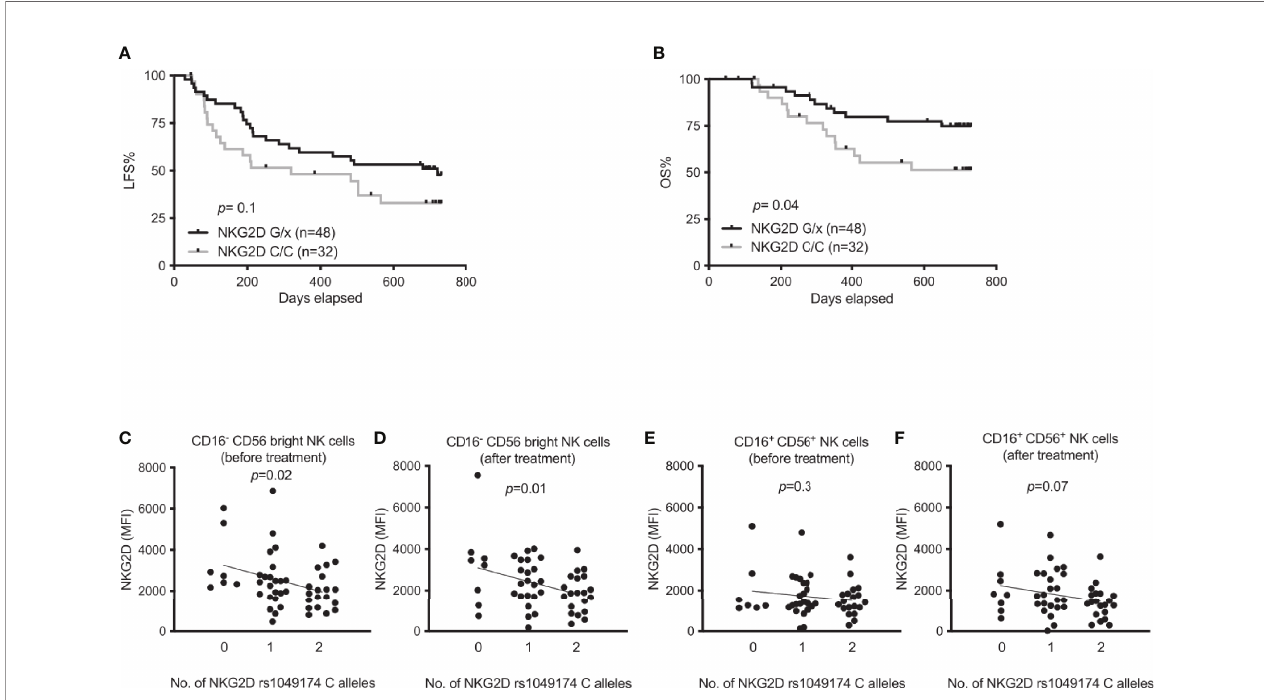
FIGURE 1 | Impact of NKG2D rs1049174 gene variants on outcome of immunotherapy in AML and expression of NKG2D. (A, B) Leukemia-free survival (LFS) and overall survival (OS) of AML patients harboring NKG2D G/x (n=48) or CC (n=32) after receiving HDC/IL-2 treatment. (C – F) NKG2D expression according to NKG2D rs1049174 genotypes in AML patients in both CD16 - CD56 bright and CD16 + CD56 + NK cells before and after immunotherapy as indicated in fi gures. Patients in fi gures (C – F) are divided according to indicated number of NKG2D rs1049174 C alleles [n equals 7, 23 and 19 before immunotherapy; panels (C, E) ; and 8, 23 and 20 after immunotherapy; panels (D, F) ]. P values were obtained using log rank test for survival in fi gures (A, B) and simple linear regression analysis was performed in fi gures (C – F)